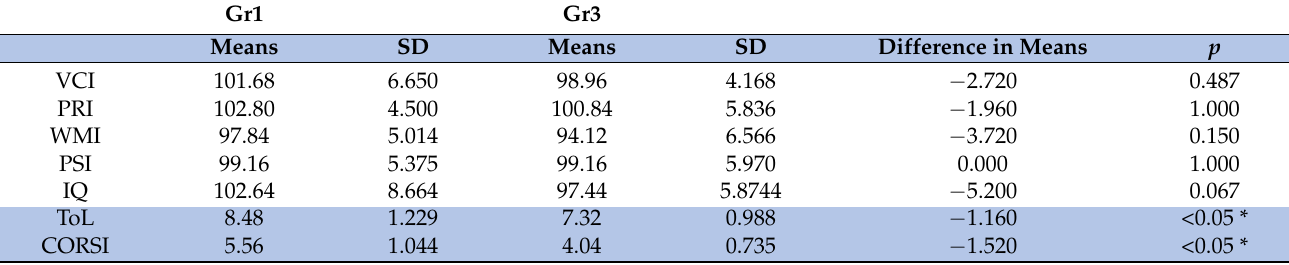
Table 2. Post hoc between Gr1 and Gr3.